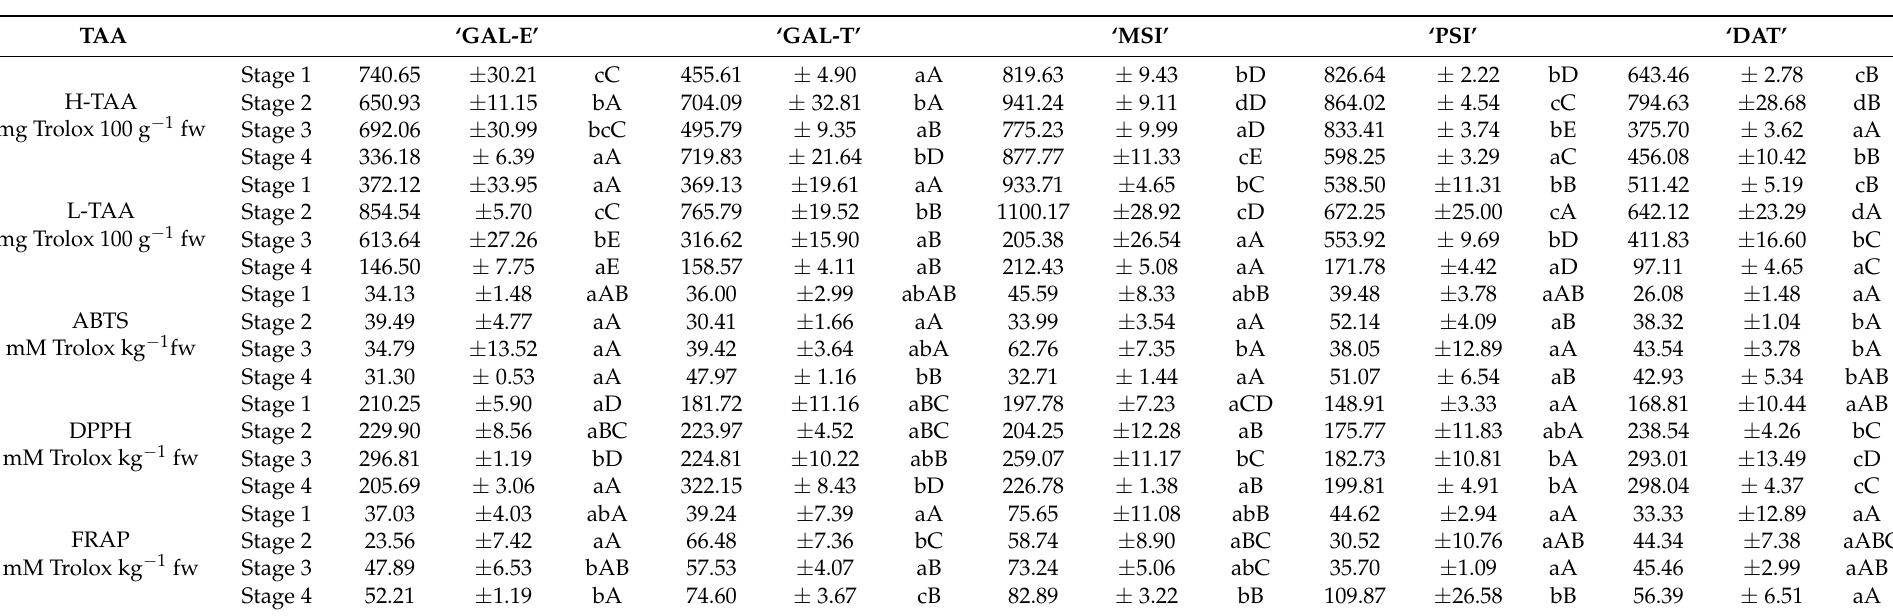
Table 3. Total antioxidant activity (TAA) (mM Trolox fw) by the ABTS, DPPH, and FRAP methods and hydrophilic and lipophilic fractions in jujube fruits.